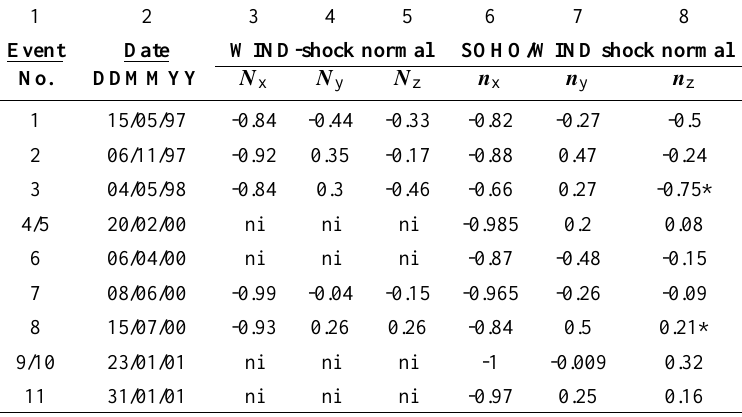
Table 4. Comparison of the components of the shock normal vectors detected at Wind with those determined using a two point method at SOHO/Wind and ACE/Wind 1